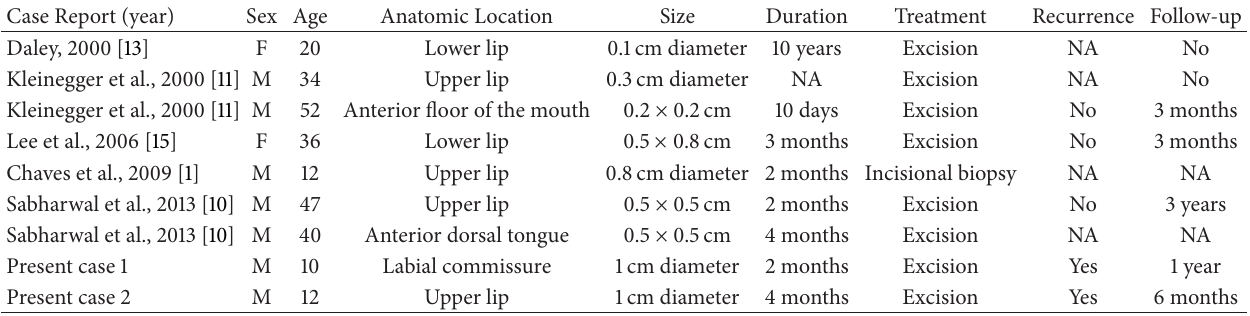
Table 1: Tufted angioma’s cases reported with oral mucosa involvement.